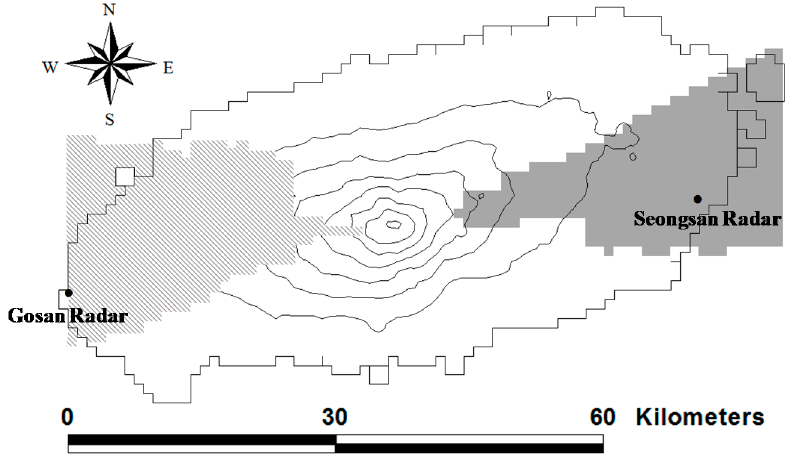
Figure 2. Location of the Gosan and Seongsan radars and their beam blocking areas (shaded area and hatched area, respectively) for the 1.5 km CAPPI.